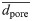
Wetting and pore dilation in the most hydrated SSH simulation.(A) Number of water molecules, N
wat, length of the largest dehydration, z
gap, and average pore diameter, dpore¯, in the MM as functions of simulation time t (z
gap and dpore¯ are in nm). Similar plots for all eight SSH simulations and representative simulations with and without regulatory ions are shown in S4 and S5 and S6 Figs, respectively. (B, C) Side view of two TmCorA protomers highlighting pore-lining sidechains and lumenal water molecules at (B) 0 and (C) 15 ns. (D, E) Extracellular view along the pore axis showing sidechains of (D) M302 and (E) L294 at (red) 0 and (blue) 15 ns.